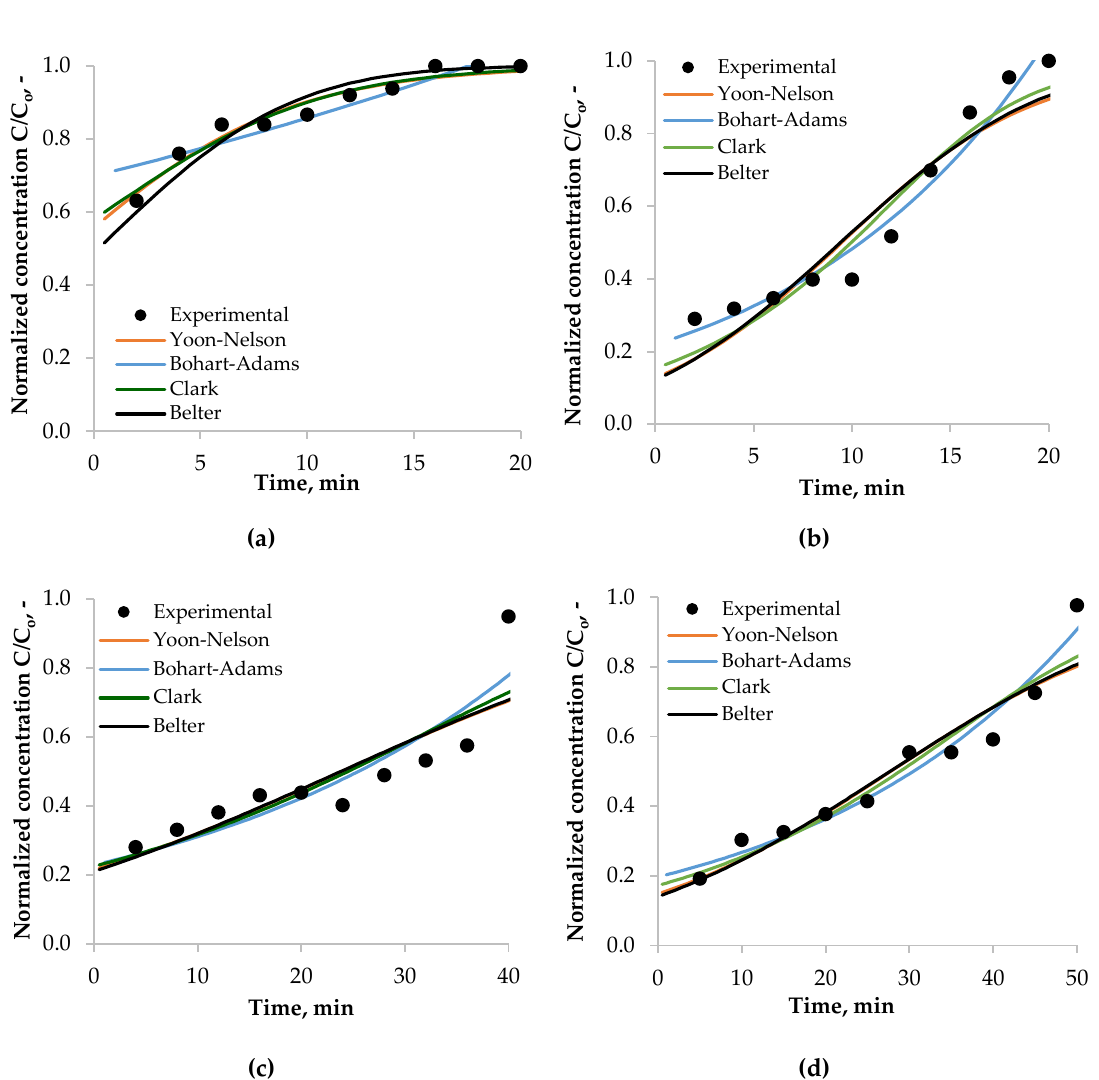
Table 2. Yoon–Nelson, Adams–Bohart, Clark, and Belter model parameters for BTX breakthrough curves.